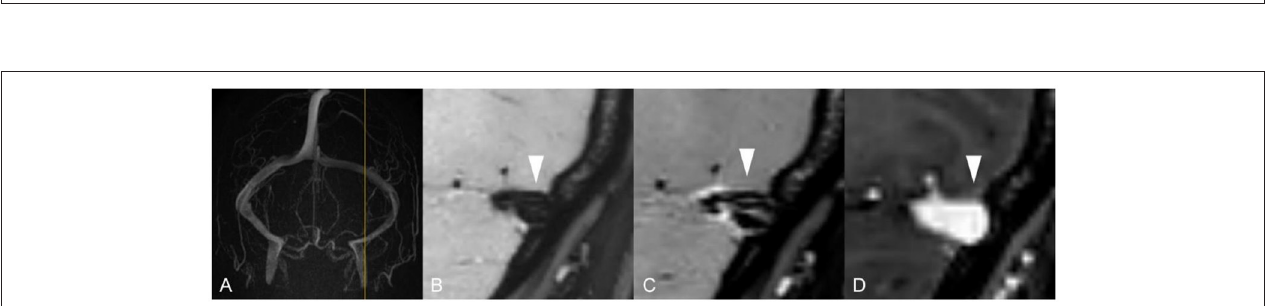
FIGURE 2 | Images reveal arachnoid granulation in a 51-year-old woman with headache. (A) MRV shows stenosis on RTS with left occlusion/ hypoplasia; (B) T1w black-blood image shows an oval arachnoid granulation that is isointense to brain parenchyma; (C) T1w black-blood contrast-enhanced image shows a an oval arachnoid granulation and an enhanced dural venous sinus wall; (D) T1w contrast-enhanced image shows a moth-eaten filling defect.